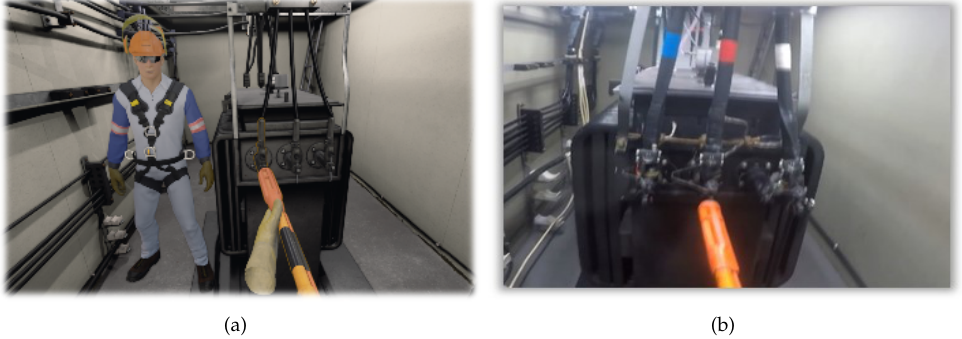
Figure 17. Virtual Training scenario Images. ( a ) virtual image; ( b ) real image.